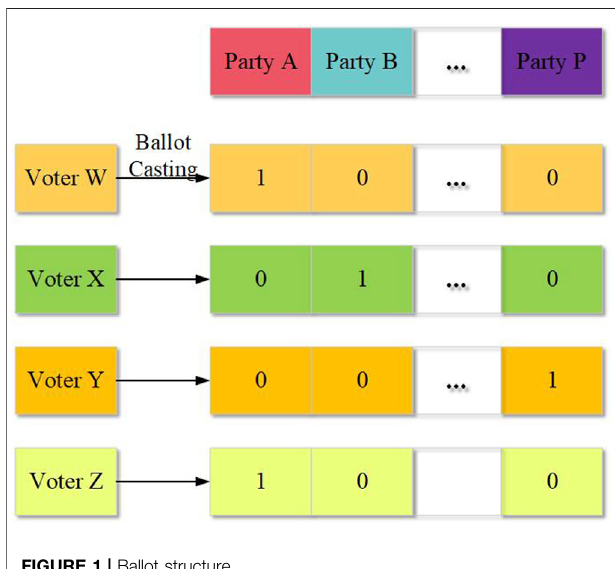
FIGURE 1 | Ballot